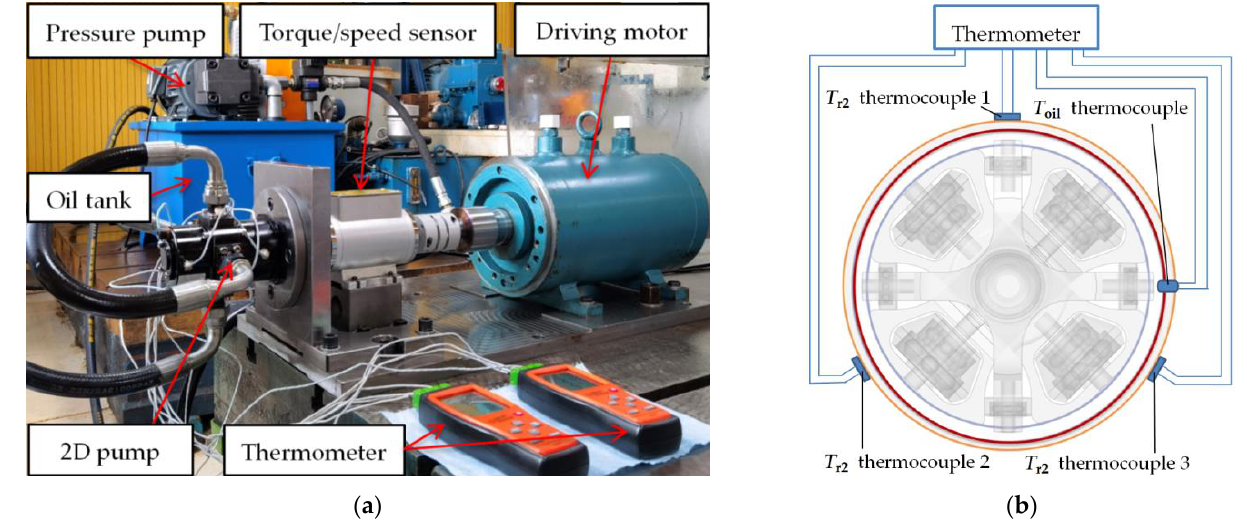
( b ) Figure 11. The heat transfer simulation of the 2D pump: ( a ) the cross-section view of the 2D pump heat transfer model; ( b ) the cross-section view of the 2D pump heat transfer simulation result at 6000 rpm. 4. Experimental Study To confirm the convective heat transfer coefficients and the theoretical heat transfer model of the 2D pump, an experimental rig, as shown in Figure 12a, was developed to